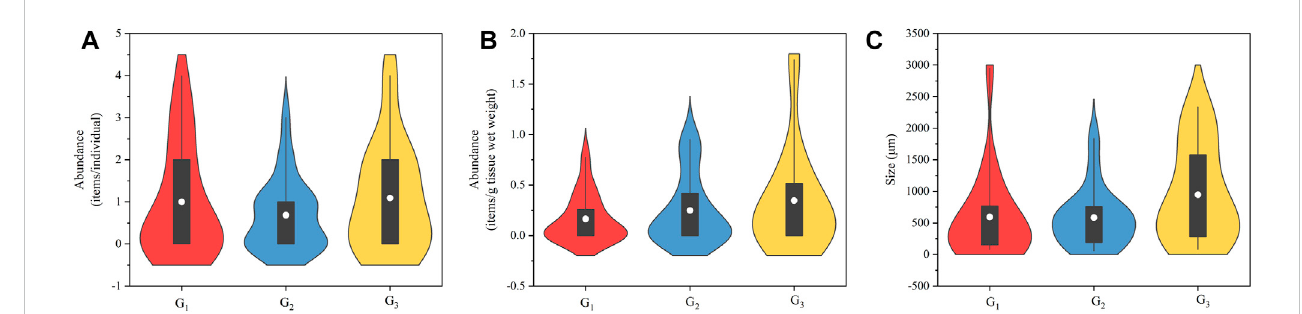
FIGURE 3 Examples of microplastics found in the stomach of jumbo squid Dosidicus gigas : fi ber in red (A) and blue (B) , fragment in blue (C) , and fi lm in transparent (D) .